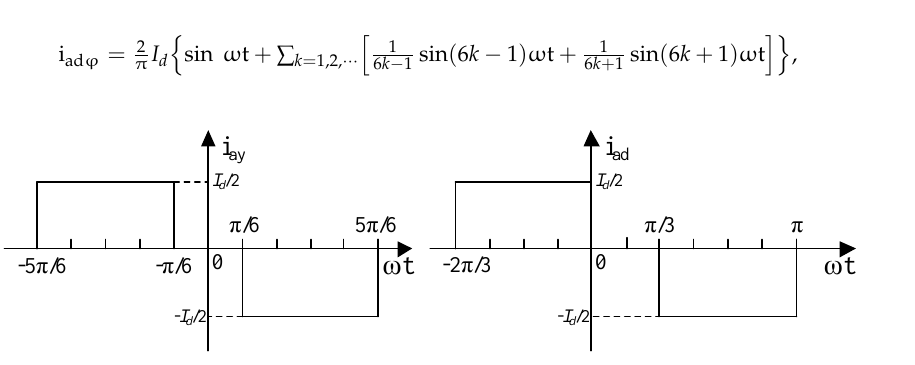
Figure 3. Input current waveform of parallel 12-pulse rectifier.